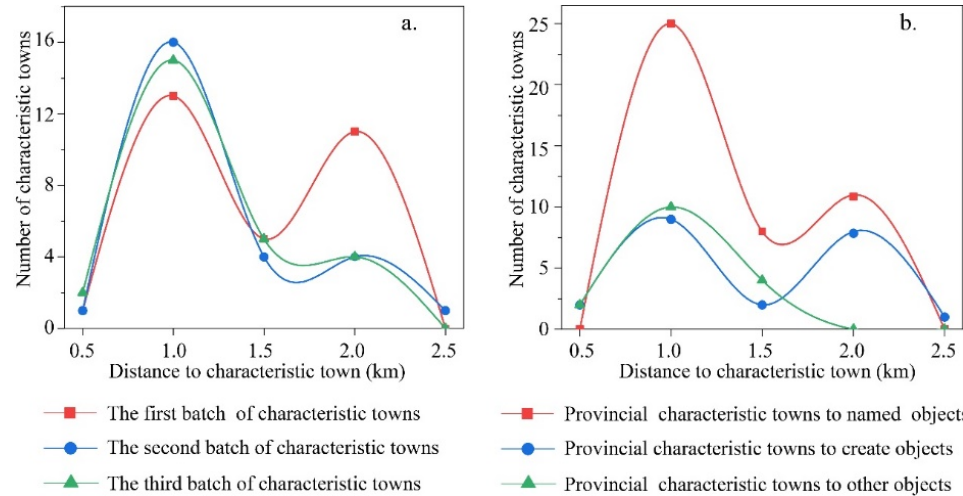
Figure 7. Gradient distribution of different types of characteristic towns. ( a ) the construction batch of characteristic towns; ( b ) the construction level of characteristic towns.